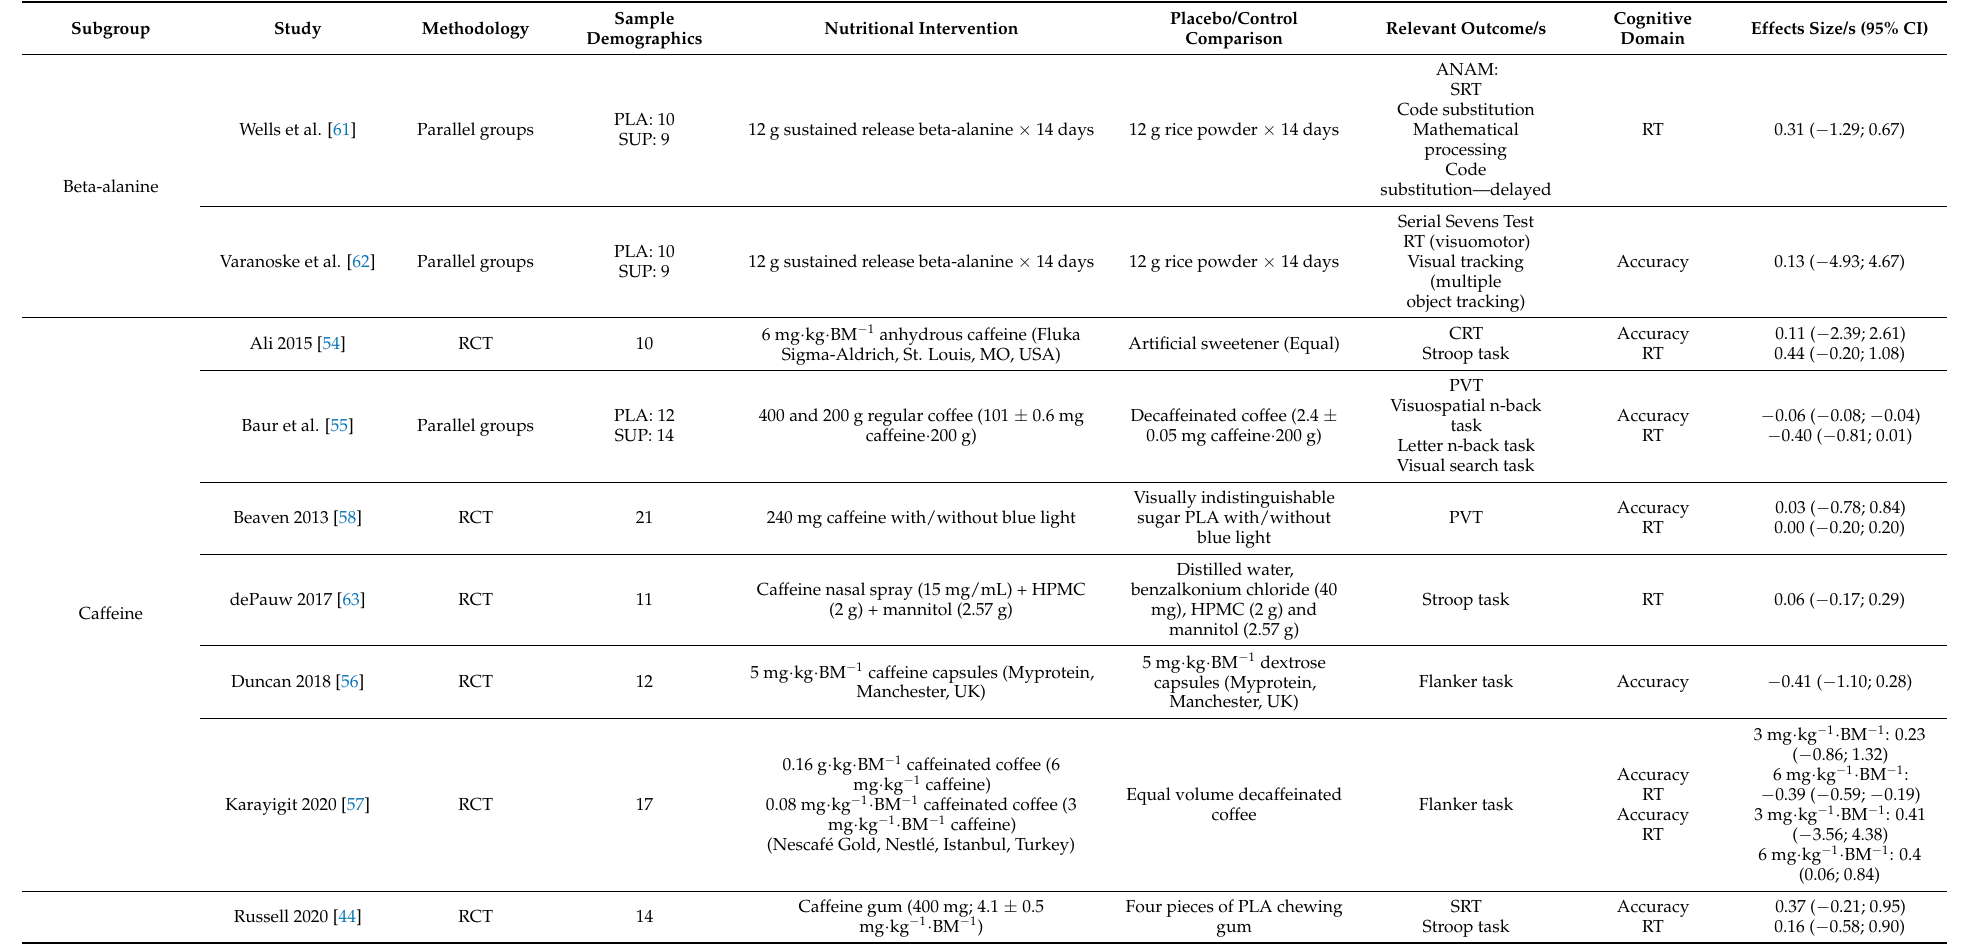
Table 2. Details of individual studies included in the